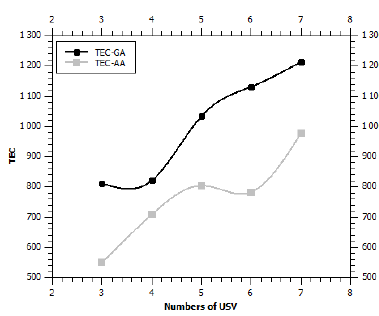
Figure 19: Displacement – cleaning en- ergy consumption in a zone with a strong degrees of dirt.